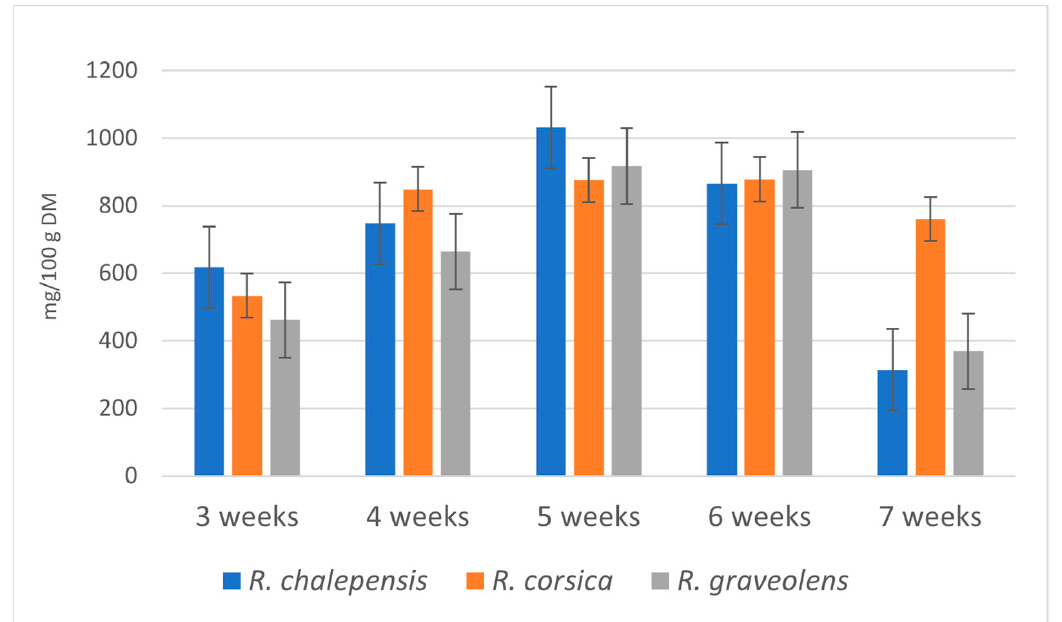
Figure 2. Total content of coumarins (mg/100 g DW) in the methanol extracts obtained from Ruta spp. in vitro cultured biomass in the consecutive weeks of the breeding cycle. Values are expressed as the mean ± SD ( n = 3).